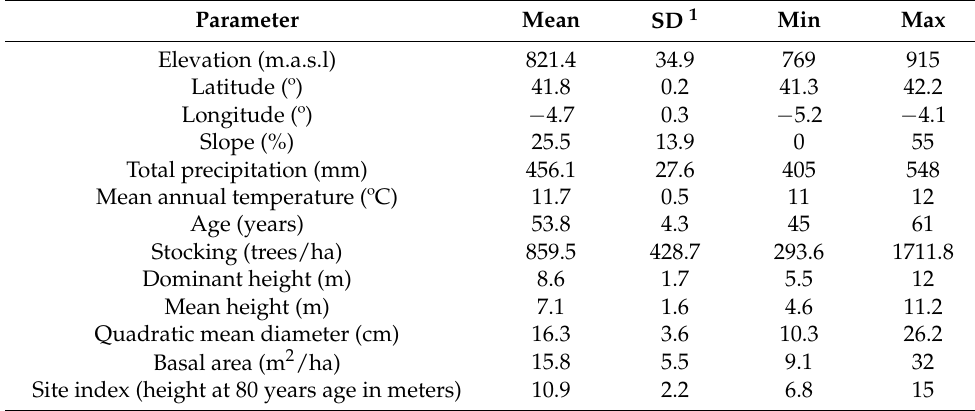
Table 1. Main stands characteristics; extracted from